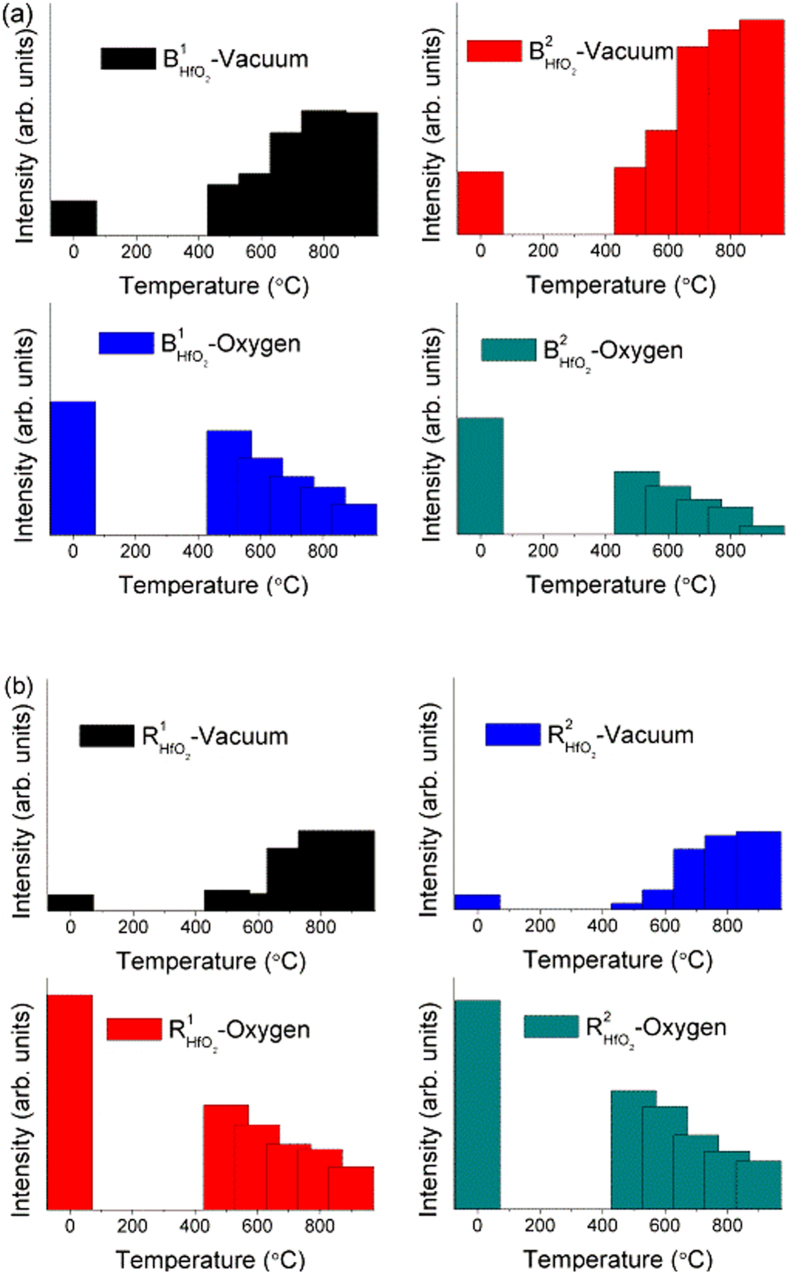
The intensities of luminescence from HfO2 vs. the annealing temperatures.(a) The blue subpeaks, i.e.,  and , annealing in vacuum and oxygen, respectively. (b) the red subpeaks, i.e.,  and , annealing in vacuum and oxygen, respectively.